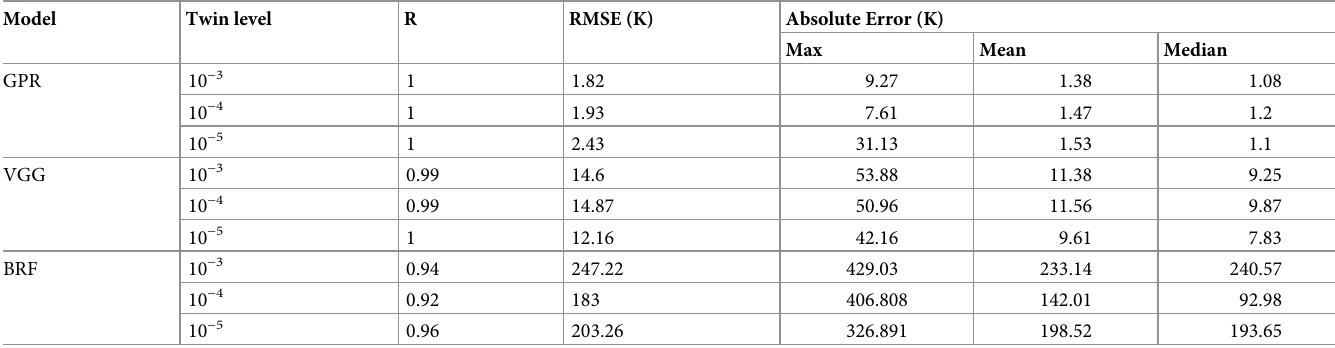
Table 7. Generalization performance of the retrained models on ten-section-profile spectra. Model